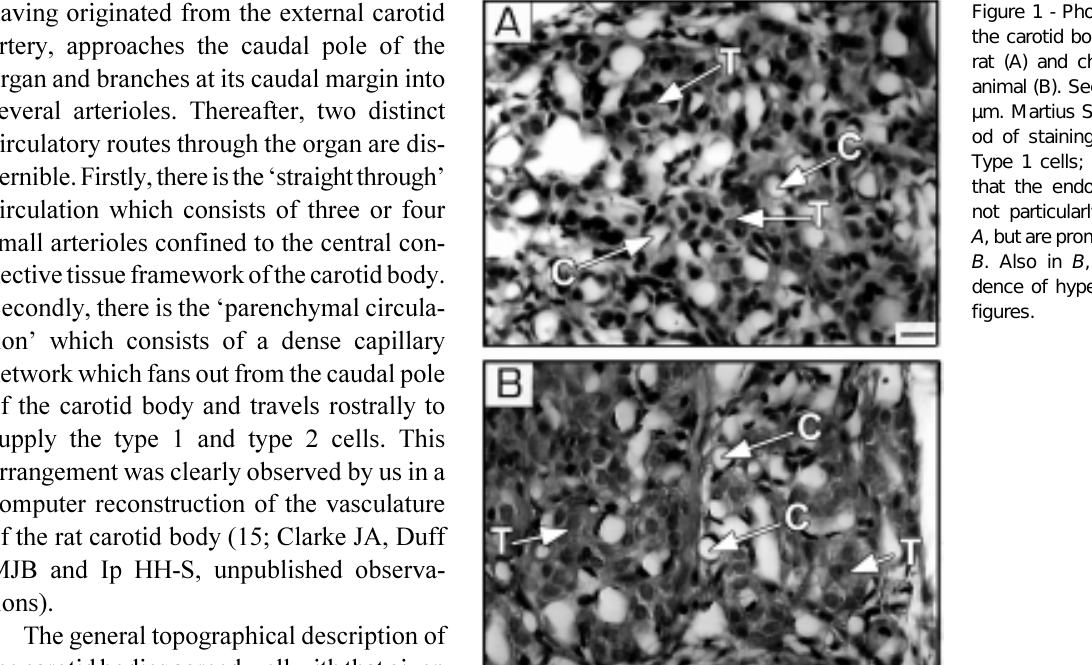
Figure 1 - Photomicrographs of the carotid body from a control rat (A) and chronically hypoxic animal (B). Section thickness, 5 µm. Martius Scarlet Blue meth- od of staining. Bar, 10 µm. T, Type 1 cells; C, capillary. Note that the endothelial nuclei are not particularly conspicuous in A , but are prominently stained in B . Also in B , there is no evi- dence of hyperplasia or mitotic